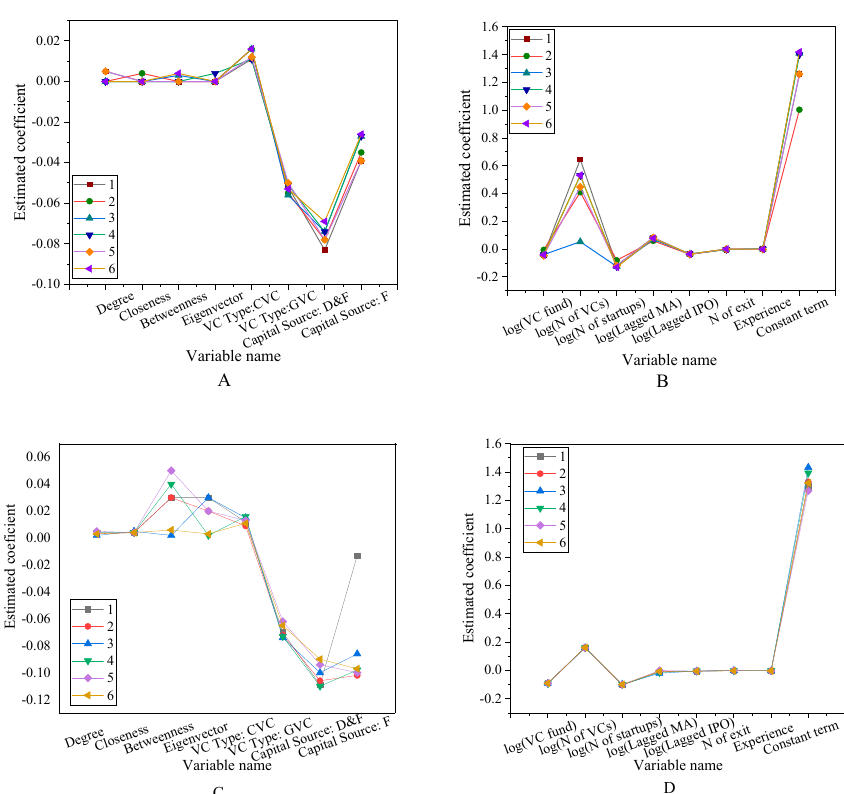
Figure 14. Robustness test of successful exit rate of social network and portfolio on region and category ( A , C ) are the first 8 variables; ( B , D ) are other variables.